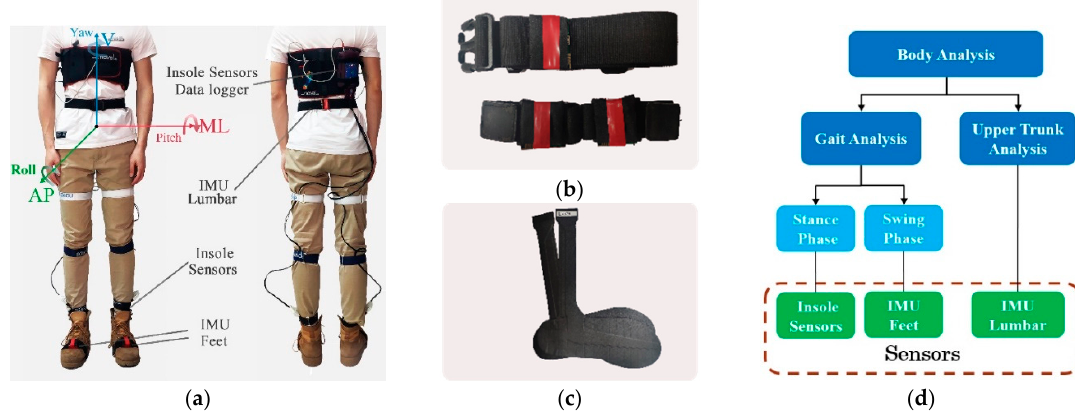
Figure 1. ( a ) Wearable sensors used in this experiment, including three inertial measurement unit (IMU) and a pair of insole sensors. Two IMU are attached to feet with elastic belt in the position that is closed to toe (IMU Feet). The other is attached to the low back, where it is closed to L3 region (IMU Lumbar). A pair of insole sensors are put into subject’s own shoes and the data logger of insole sensors is fastened in the subject’s body. In addition, mediolateral (ML), vertical (V), anterior-posterior (AP), Pitch, Roll and Yaw directions are shown. ( b ) Representation of three IMU with elastic belt. ( c ) A pair of insole sensors (Novel, Germany). ( d ) A diagram of human body analysis using insole sensors and IMU.